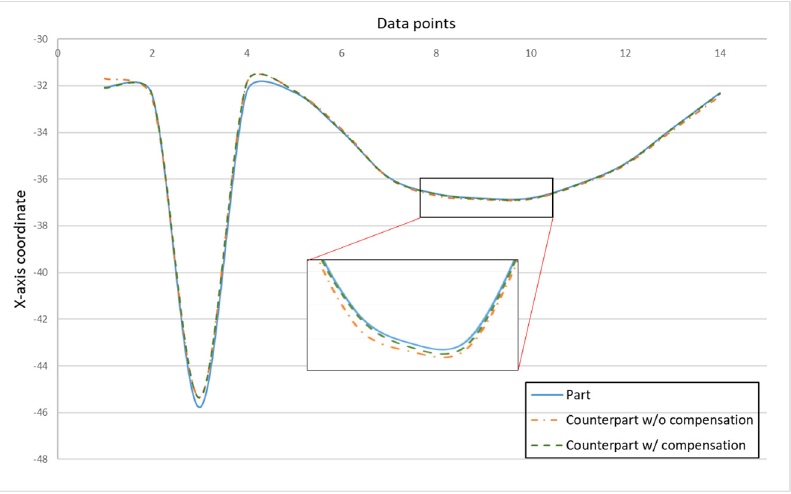
Figure 18. Error comparison between counterpart w/o compensation vs. counterpart w/ compensa- tion for complex mating.